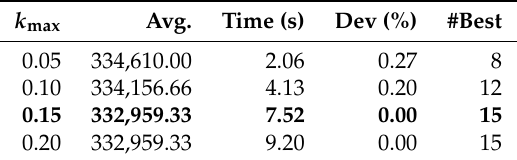
Table 3. Comparison of the different k max values considered in the Basic Variable Neighborhood Search (BVNS) algorithm.